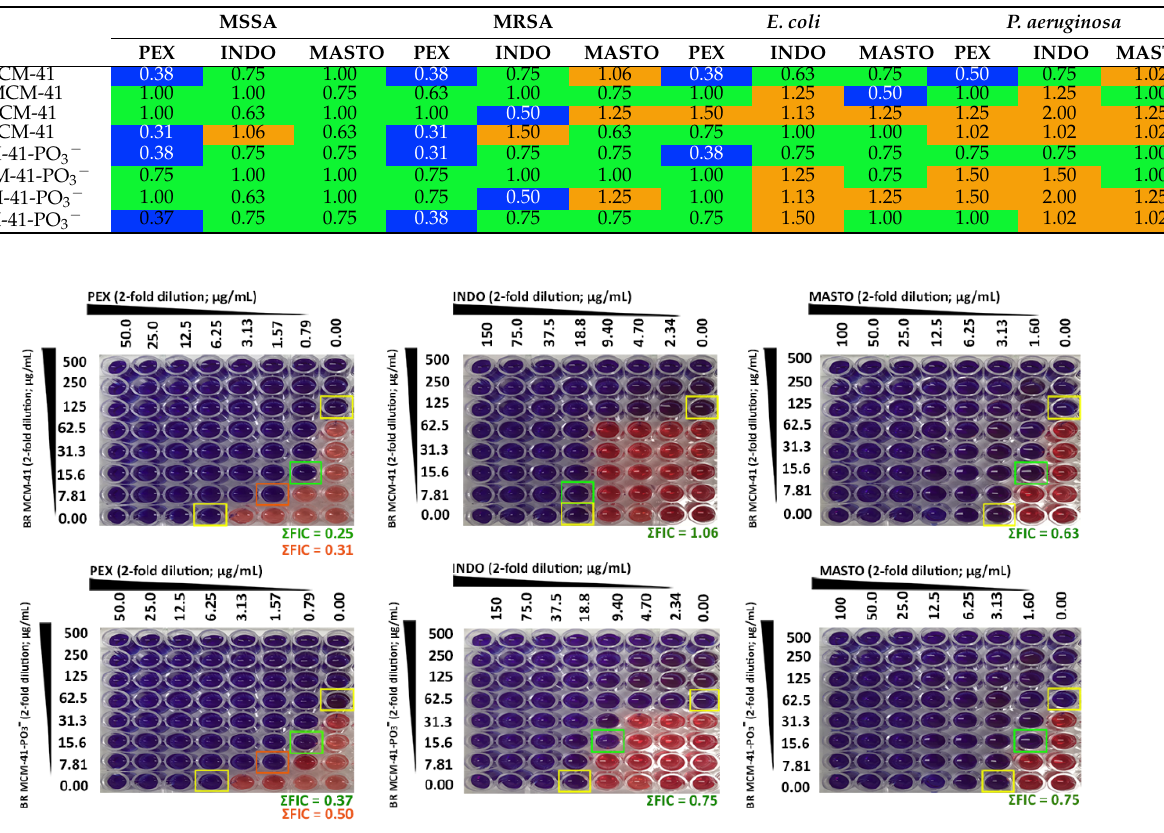
Figure 6. Visual recording of checkerboard assay data ( Σ FIC) for BR-loaded MCM-41 and MCM-41-PO 3 − MSNs in combination with AMPs (PEX, INDO, and MASTO) against MSSA (ATCC25923).